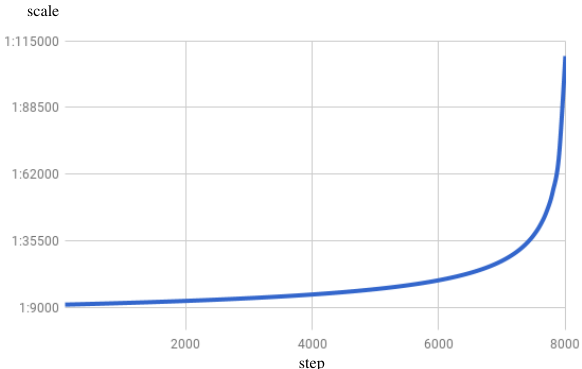
Figure 4. Graph of relationship between number of objects and scale for sample data, where S b = 10 , 000 and N b = 8 , 068